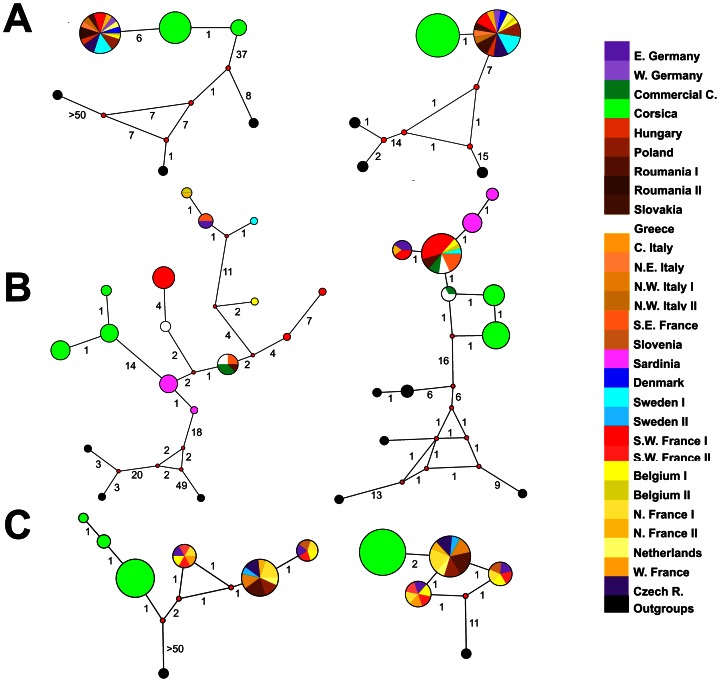
Median-joining network of haplotypes found in 4 model species ranges based on COI (on the left) and Cytb (on the right).A = B. lucorum; B = B. terrestris; C = B. vestalis. The sizes of the circles are proportional to frequencies of haplotypes. The red points on the lines represent undetected/extinct intermediate haplotype states. The numbers on the lines represent the number of mutations between two close haplotypes. The black circles are outgroups (see Table S1).